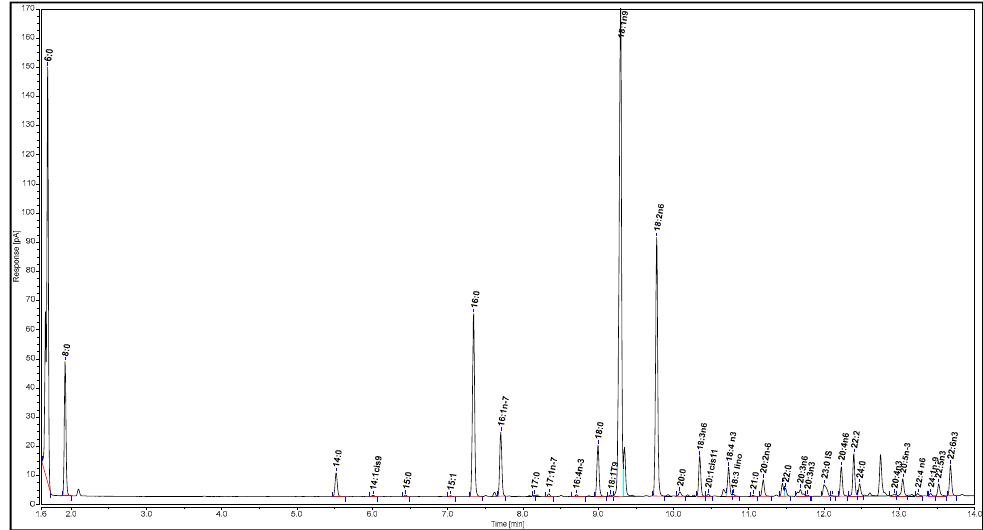
Figure 2. Gas chromatogram of Atlantic salmon oil.